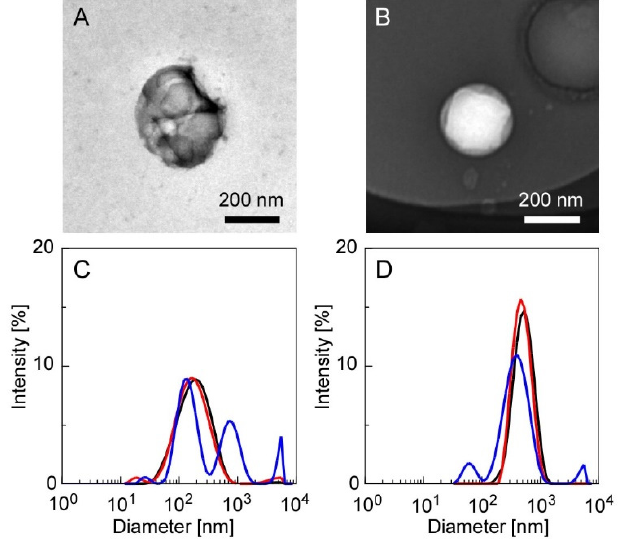
Figure 2. TEM images of the CS(Ns) and PLL(Ns) nanoparticles, and their respective diameter dis- tributions evaluated by DLS (( A , C ): CS(Ns) nanoparticles and ( B , D ): PLL(Ns) nanoparticles). Meas- urement conditions: 25 °C (black trace), 70 °C (red trace), and 70 °C after homogenization at 12,000 rpm for 5 min (blue trace).